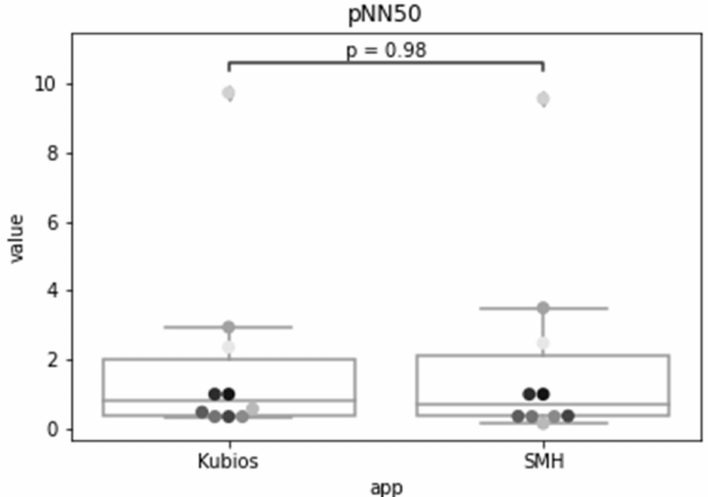
Figure 18. Results for the percentage of successive RR intervals that differ by more than 50ms (pNN50) using Kubios and SMH.